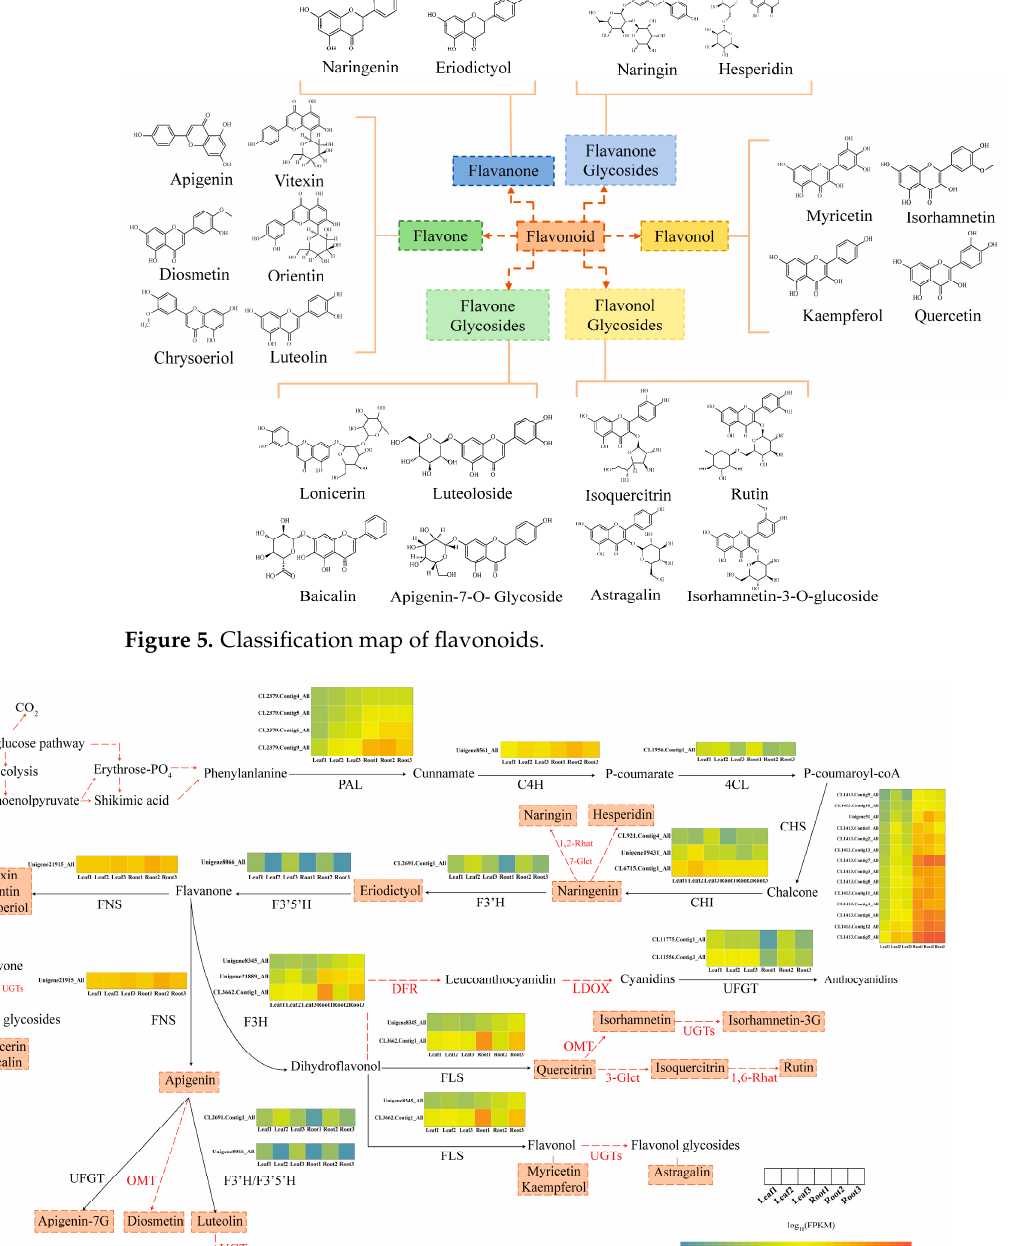
Figure 5. Classification map of flavonoids.